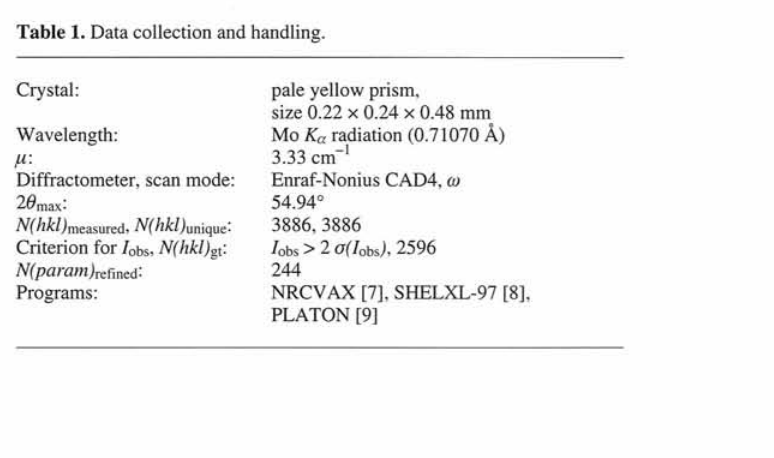
Table 1. Data collection and